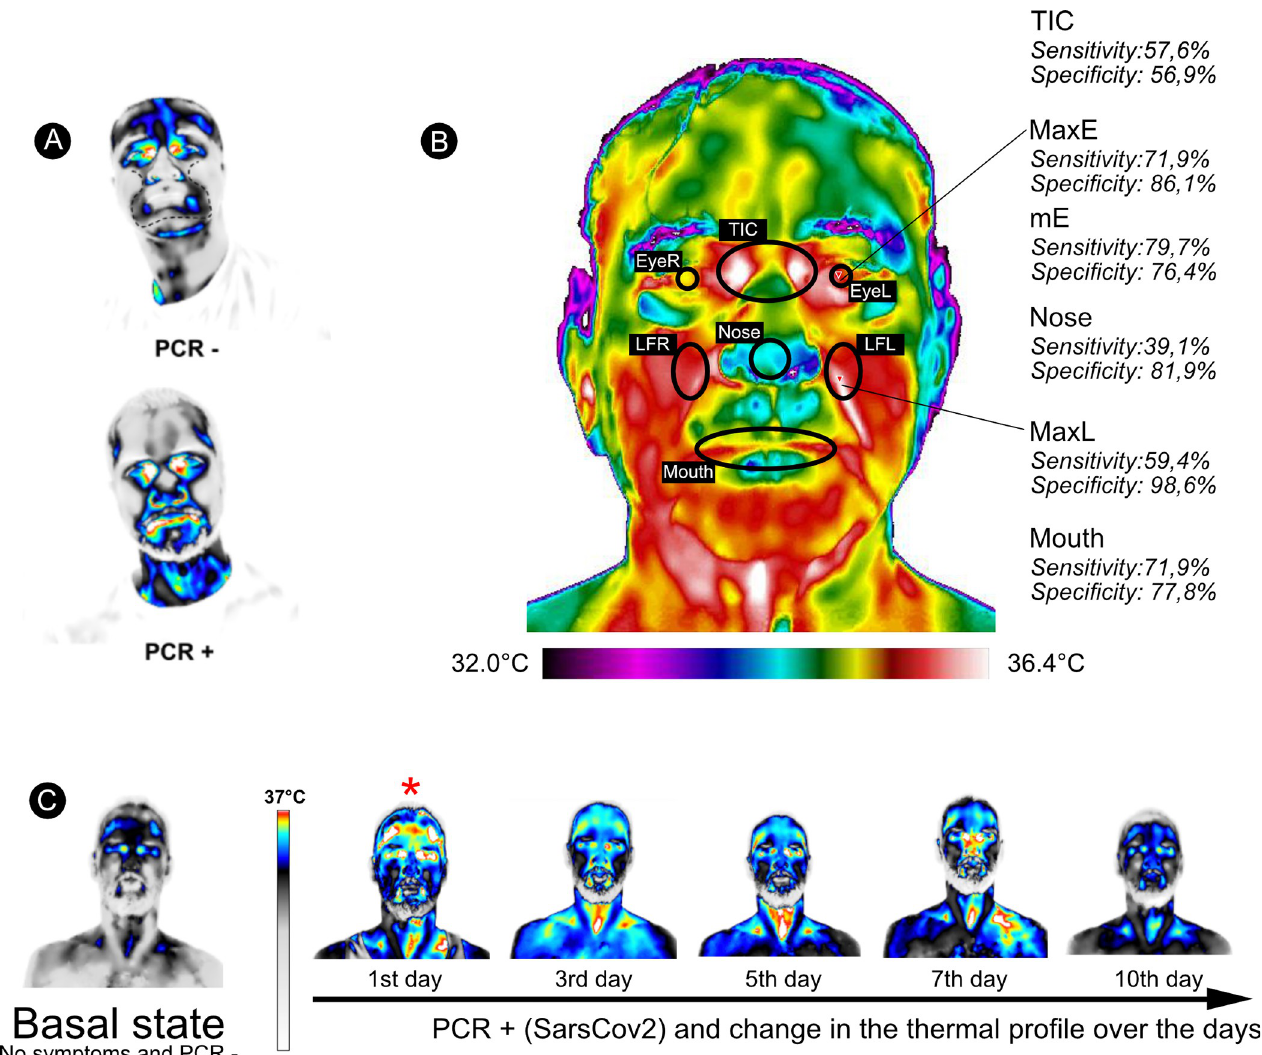
Fig 2. Thermal image profile of the analyzed patients’ faces. (A) The dotted line describes the region with the greatest significant difference between patients tested positive (PCR+) and negative (PCR-) for COVID-19; (B) Regions with greater sensitivity and specificity in the evaluation of the thermal image: MaxE (maximum temperature of the Eyes), MaxL (maximum temperature of the lateral of the nose), mE (mean temperature between the eyes), Nose (mean temperature of the nose surface), Mouth (mean temperature of the mouth) and (C) Evolution of facial thermal profile of a subject during the infection period (according to sequential PCR results), showing that IRT captured fever (T > 37.5˚C) only in the first day of infection.